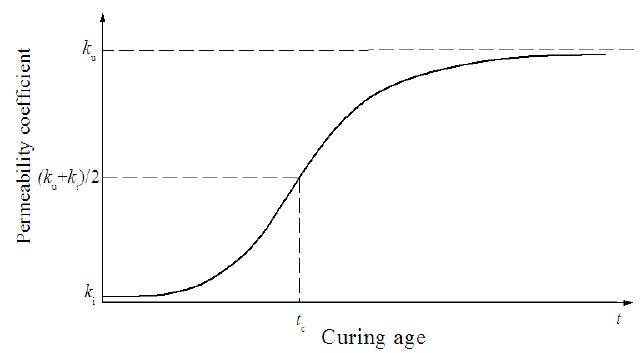
ffi cient of the deteriorated layer.